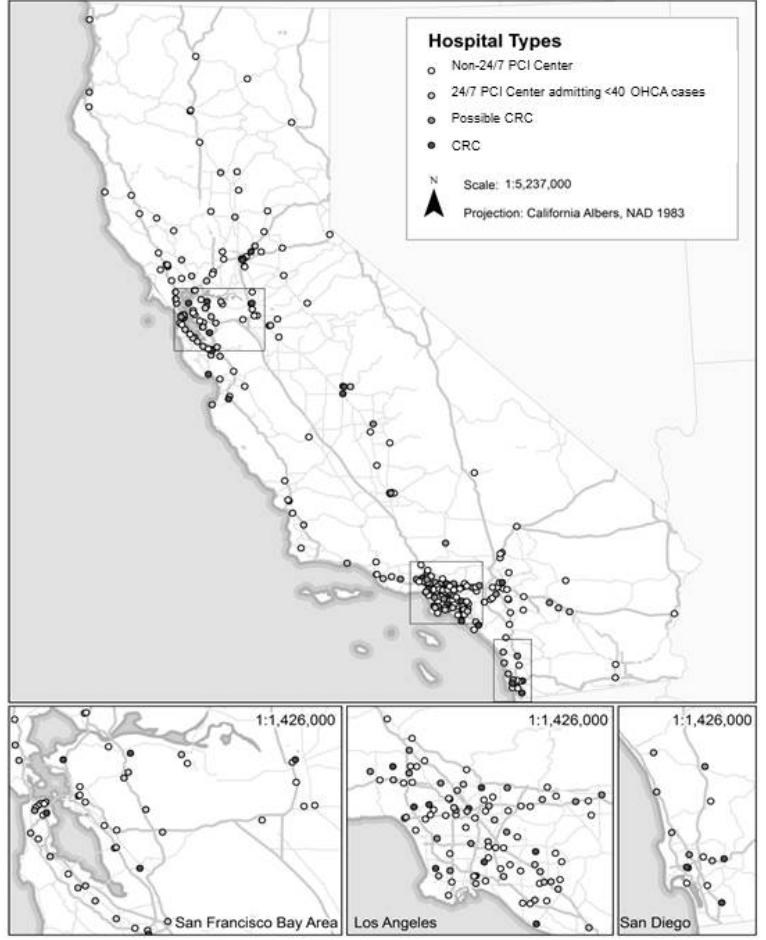
Figure 2. Geographic distribution of cardiac resuscitation